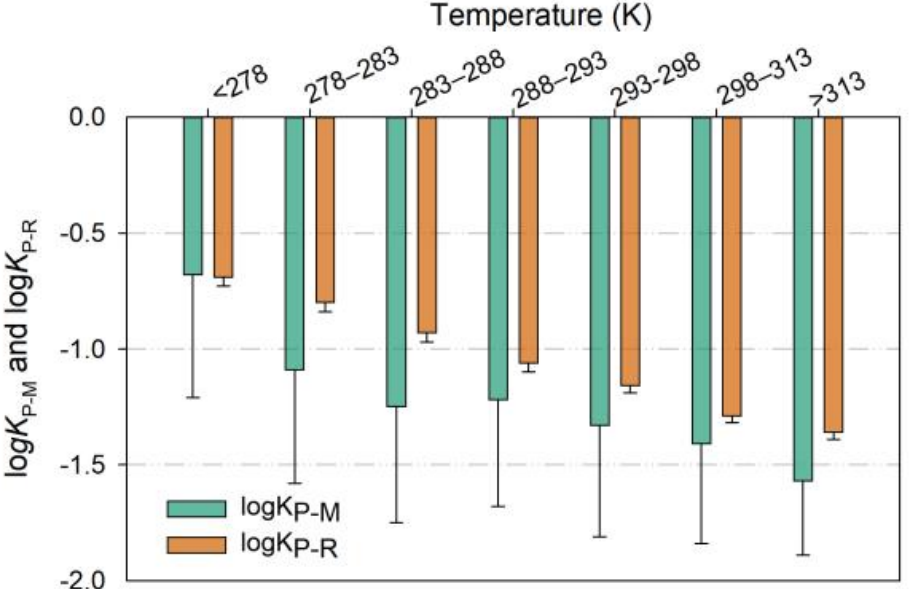
Figure 3. Comparison of the log K P values obtained from field measurement, empirical regression model prediction.